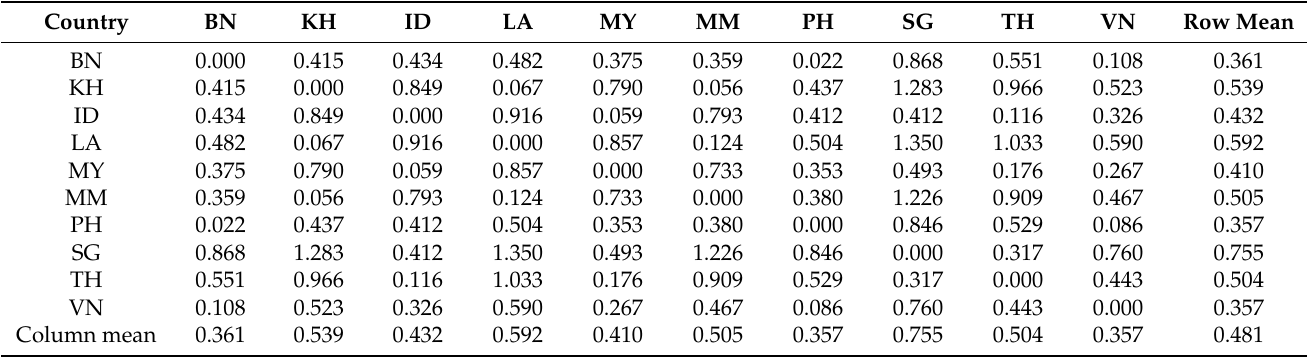
Table A1. Euclidean distance matrix for criterion C1.